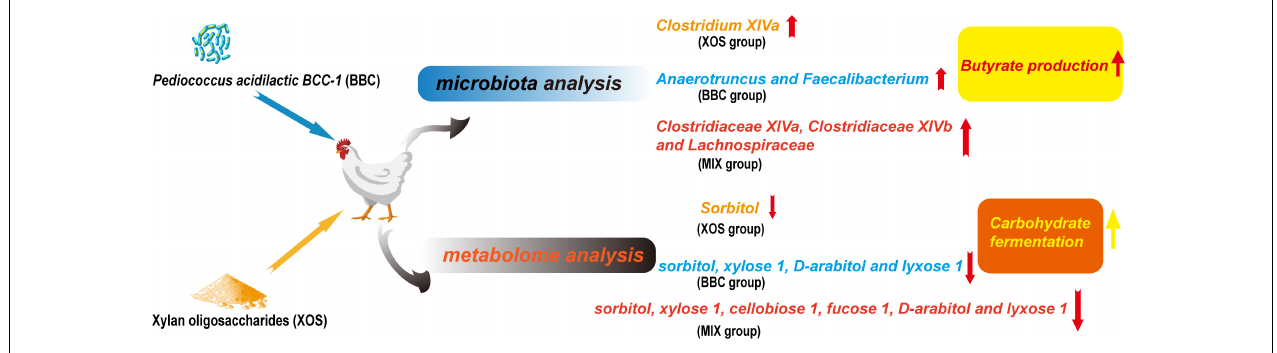
FIGURE 5 | Graphic abstract of the influence of XOS and BBC treatment on cecal microbiota and metabolome of broilers.